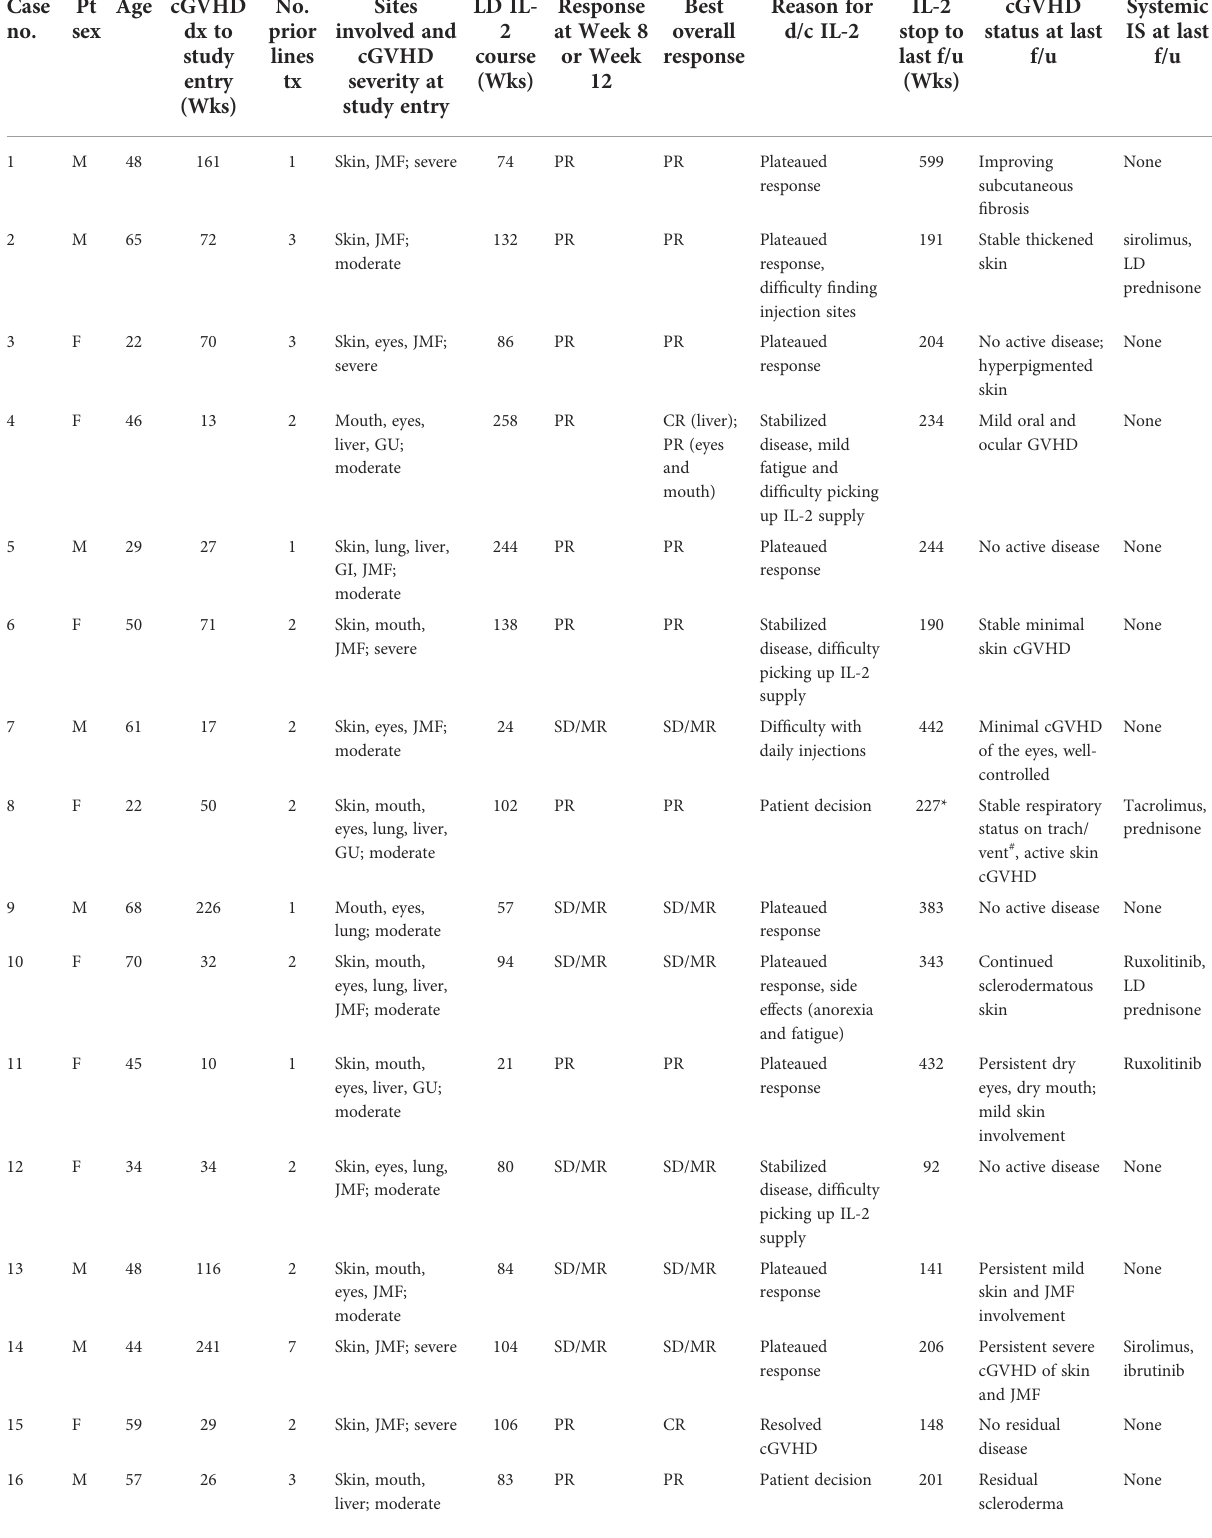
TABLE 2 Clinical course during and after low-dose IL-2 therapy. Case